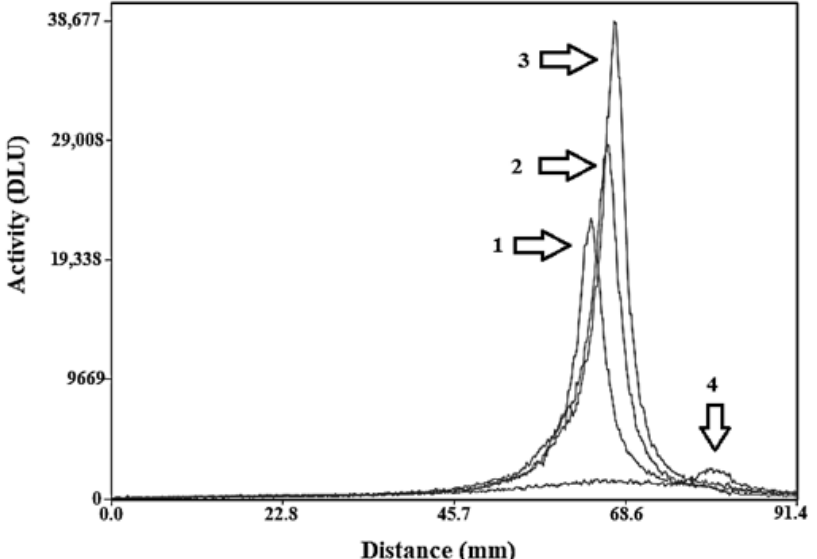
Figure 3. SDS–PAGE analysis of 99m Tc-labelled affibody molecules. (1) [ 99m Tc]Tc-ZHER2:41071, (2) [ 99m Tc]Tc-ZHER2:2395, (3) [ 99m Tc]Tc-ZHER2:V2 and (4) 99m TcO 4 − . The signal was measured as digital light units (DLU) and is proportional to radioactivity at a given point of a lane in the SDS-PAGE gel. Note that the applied activity of 99m TcO 4 − was lower compared to applied activity of affibody